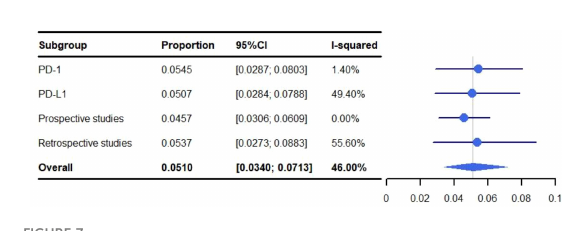
FIGURE 7 Subgroup analysis of meta-analysis and forest plot for non-small cell lung cancer patients treated with radiotherapy/chemoradiotherapy and immune checkpoint inhibitors who experienced grade 3-5